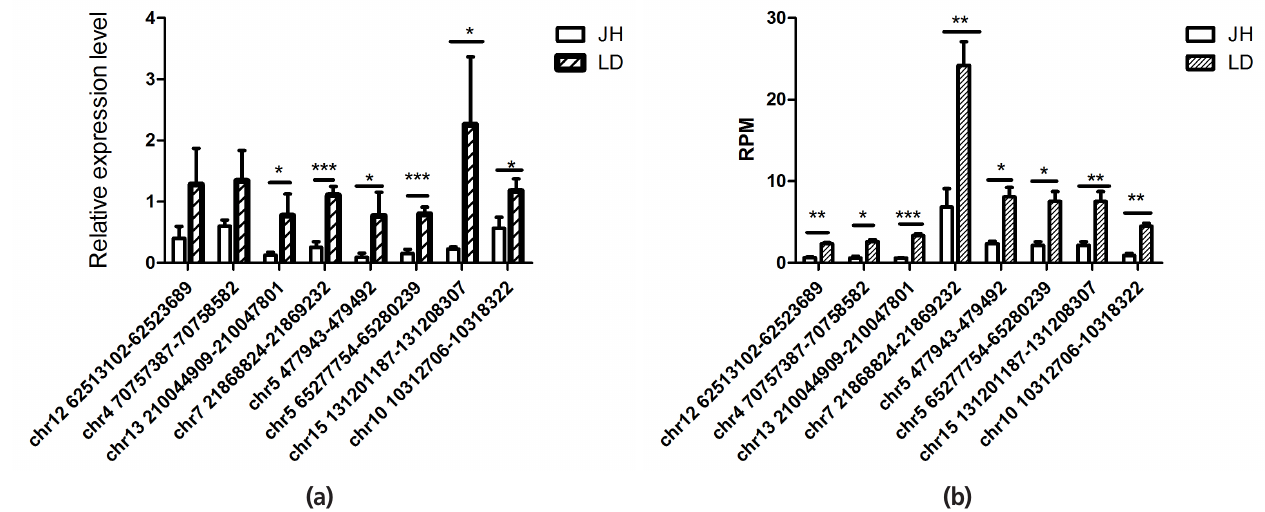
Figure 5. Validation of circular RNA sequencing results by quantitative real-time polymerase chain reaction (qRT-PCR). (a) Sequencing data and (b) qPCR